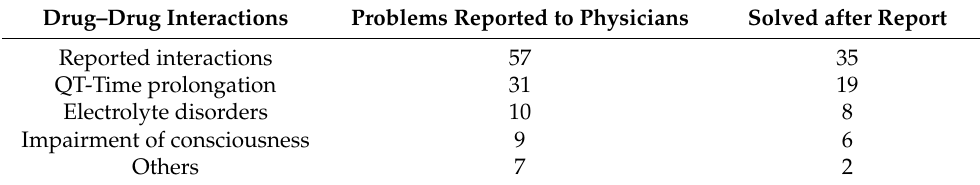
Table 2. Drug–Drug Interaction related MRP reported and resolved.